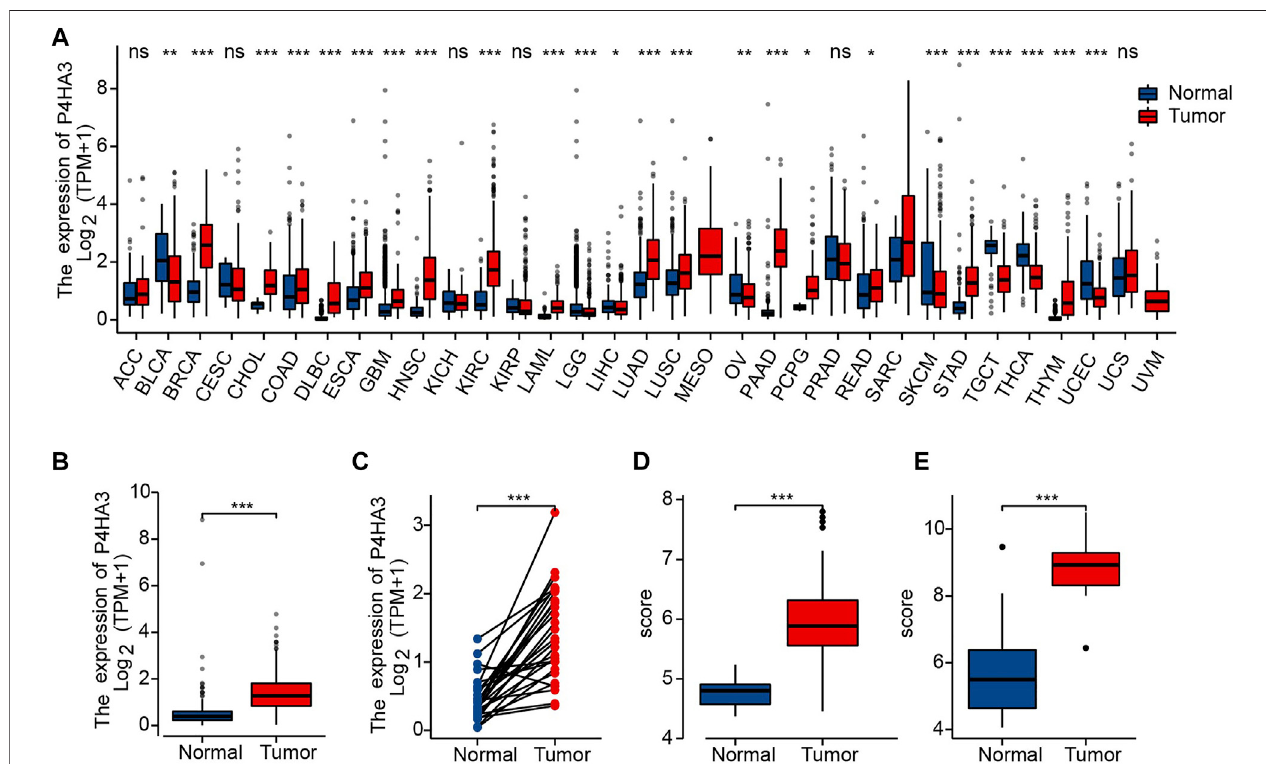
FIGURE 2 | Upregulation of P4HA3 in GC. (A) P4HA3 expression levels in various cancer-types from TCGA data; (B) P4HA3 transcript levels in GC and non- cancerous gastric tissues from TCGA data; (C) P4HA3 expression in paired samples; (D) P4HA3 expression in GSE54129; (E) P4HA3 expression in GSE103236. (ns, p ≥ 0.05; *, p < 0.05; **, p < 0.01; ***, p < 0.001.) Abbreviations: P4HA3, prolyl 4-hydroxylase subunit alpha 3; GC, gastric cancer; BRCA, breast invasive carcinoma; CHOL, cholangiocarcinoma; COAD, colon adenocarcinoma; DLBC, lymphoid neoplasm diffuse large B-cell lymphoma; ESCA, esophageal carcinoma; GBM, glioblastoma multiforme, HNSC, head and neck squamous cell carcinoma; KIRC, kidney renal clear cell carcinoma; LAML, acute myeloid leukemia; LUAD, lung adenocarcinoma; LUSC, lung squamous cell carcinoma; PAAD, pancreatic adenocarcinoma; PCPG, pheochromocytoma and paraganglioma; READ, rectum adenocarcinoma; THYM, thymoma; STAD, stomach adenocarcinoma; THCA, thyroid